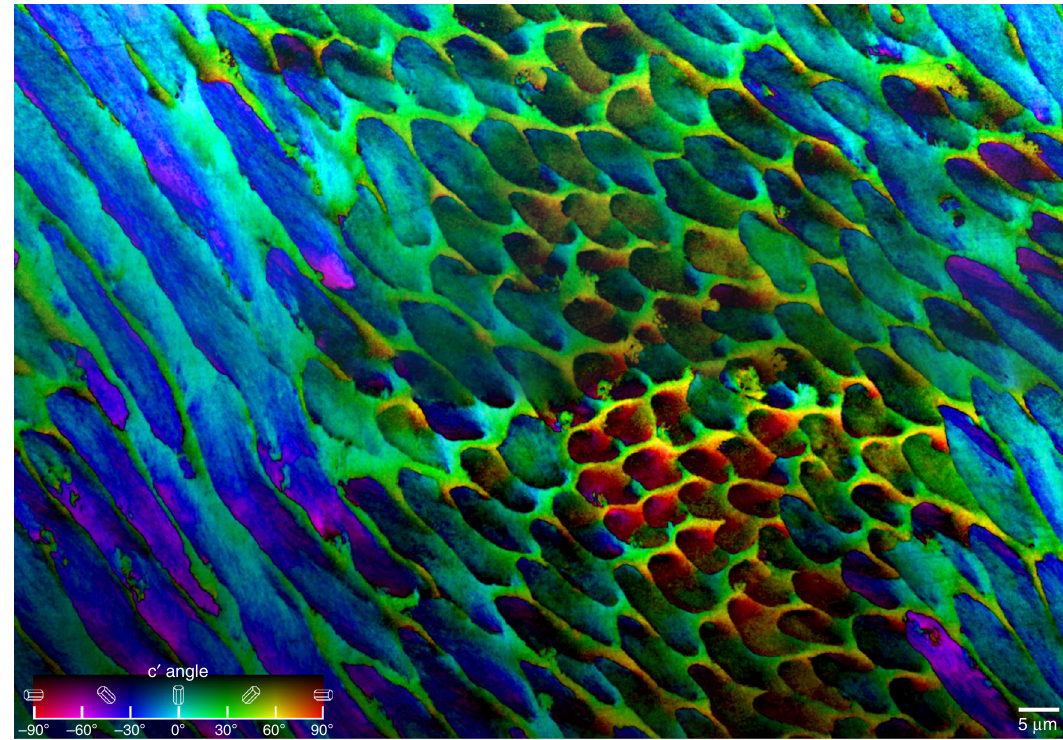
Fig. 2 PIC mapping reveals the hidden crystal orientation structure in a large area of inner enamel. The map shows Hunter – Schreger bands, or decussation pattern, in inner enamel, with three groups of rods exposed on this polished surface: in longitudinal (left), transverse (right of center), and oblique (center, right) cross-sections. See Supplementary Fig. 3 for the exact position of this area in the